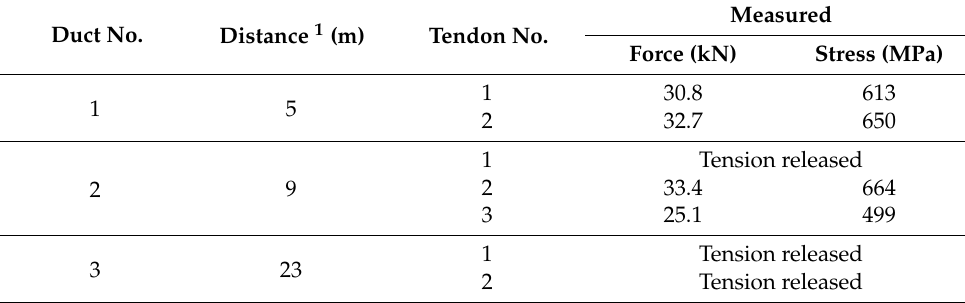
Figure 4. Evaluation of internal tendon force. Table 1. Result of internal tendon force